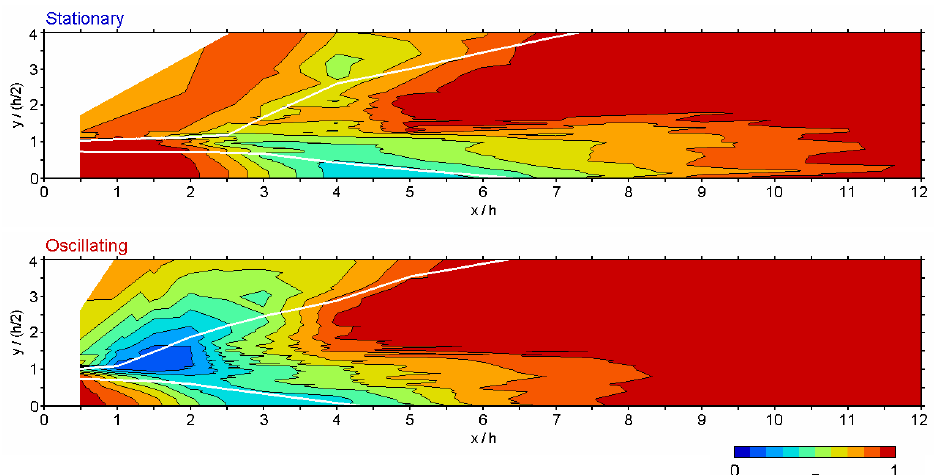
Fig. 14 Isocontour maps of randomness